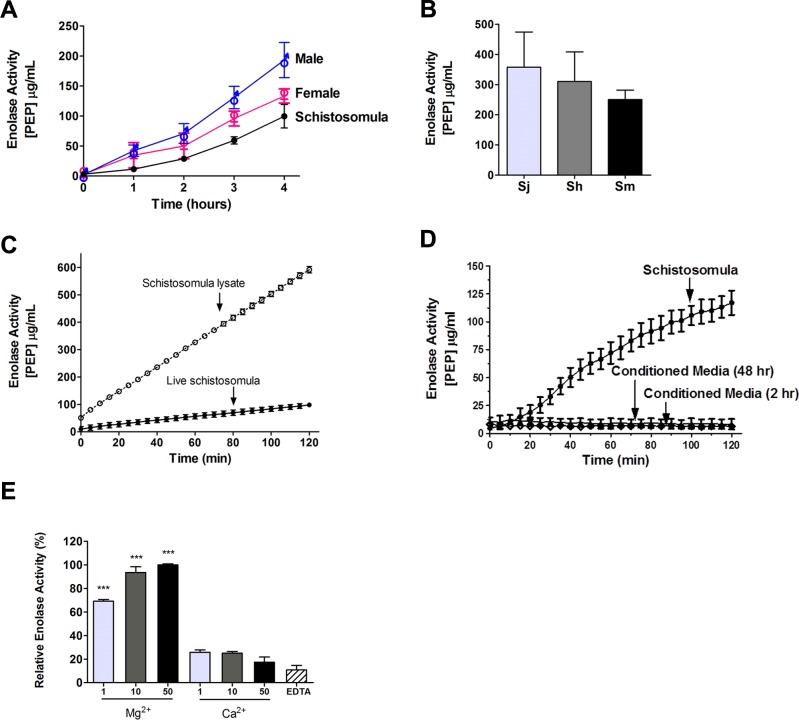
Schistosome enolase activity (mean PEP generated (μg/ml) +/- SD).(A) Enolase activity exhibited by live adult male or adult female worms (individuals) or schistosomula (~1000 parasites/sample) (n ≥ 10 replicates/sample). (B) Enolase activity exhibited by live S. japonicum (Sj), S. haematobium (Sh) and S. mansoni (Sm) adult males after 4 hours, n ≥ 12 replicates/sample. (C) Enolase activity exhibited by live schistosomula (~1,000/sample, black squares) versus total schistosomula lysate (open squares) over 2 hours, n ≥ 5/condition. (D) Enolase activity exhibited by live schistosomula (~1,000/sample, black circles) versus 2 h (open diamond) or 48 h (closed diamond), conditioned medium, n ≥ 5/condition. (E) Effect of varying divalent ion (Mg2+ or Ca2+) concentration (1, 10 or 50 mM as indicated) on mean relative enolase activity. The highest activity value (in 50 mM Mg2+) was set at 100% and activities relative to this are presented (n ≥ 5/condition). Significant differences relative to equivalent measurements containing Ca2+ are denoted by *** for p <0.001. EDTA is Ethylenediaminetetraacetic acid.